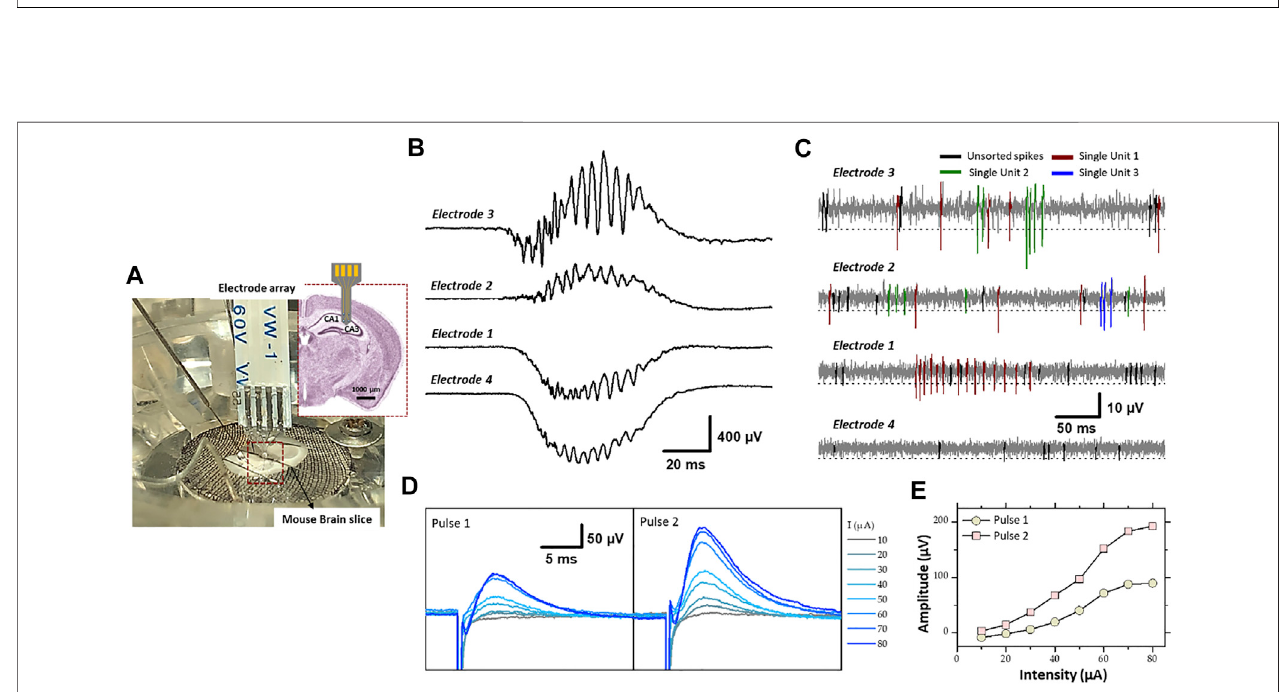
FIGURE 8 | (A) Experimental set-up of the electrophysiological recording and stimulation, in the hippocampal region (CA1 and CA3) of a mouse brain slice, using fl exible microelectrode array modi fi ed with PEDOT-CNF composite. Recording of spontaneous (B) sharp wave-ripples ( fi lter: 0.1 Hz – 3 kHz) and (C) fi ring of action potentials from neurons ( fi lter: 300 – 3,000 Hz). Electrodes 3 and 2 were located in the pyramidal cell layer of CA1, and electrode 1 and 4 were in the dendrite layers. A threshold of -3xRMS [dashed line in (C) ] was used for spike sorting. Single-units were identi fi ed using PCA and cluster analysis. Single-units are differentiated by color codes. Spikes in black correspond to unsorted (multiunit) activity. The traces in (B,C) were not obtained simultaneously but sequentially. (D) Evoked fi eld potential recordedinthepyramidalcelllayerafterelectricalstimulationoftheSchaffercollateral.Pairsofcathodicsquarecurrentpulses(200 µswidth),withaninterpulseintervalof 20 ms, were applied at 0.5 Hz. Responses evoked by the fi rst and second stimulus of the pairs are shown separately (pulse 1 and pulse 2). The different traces correspond to the response obtained at different stimulation intensities (10 – 80 µA). Each trace is the average of 10 – 20 responses obtained at a given intensity. (E) Field potentialamplitude represented asafunctionofstimulationintensity (For interpretation ofthereferencestocoloursin this fi gure legend, thereader isreferred to theWeb version of this article).